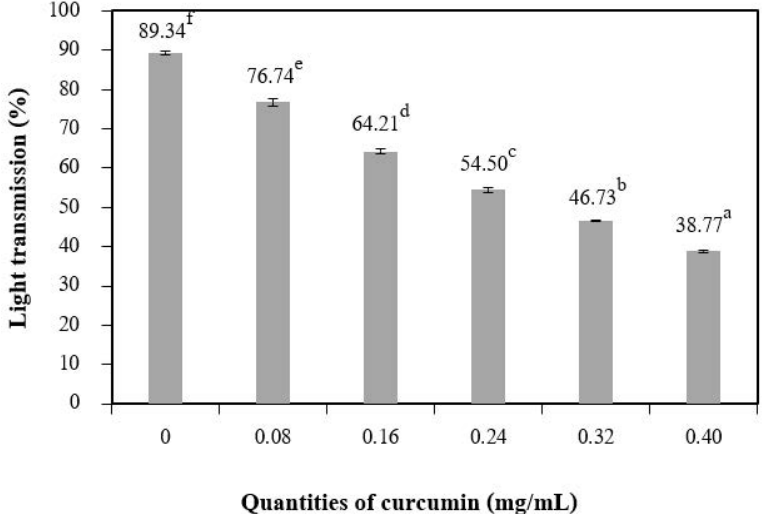
Figure 3. Light transmission of chitosan film incorporated with various curcumin quantities. Results marked with different letters are statistically different ( p < 0.05).